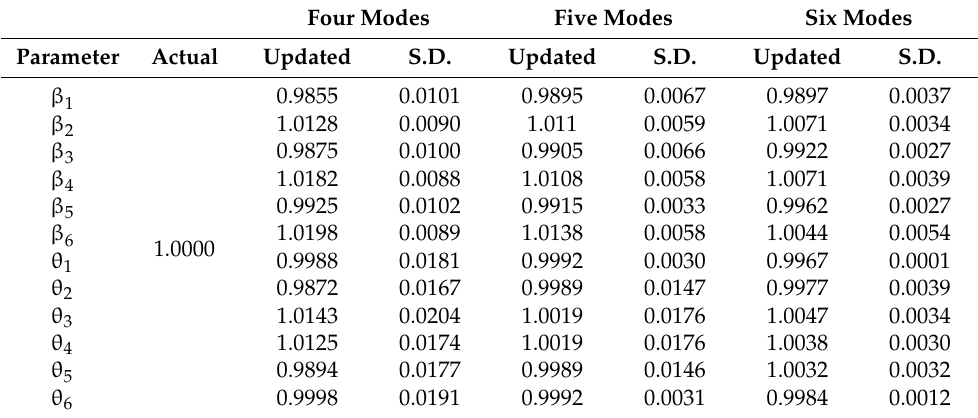
Figure 3. Updated mode shapes using incomplete modes. Table 2. Results of updated structural